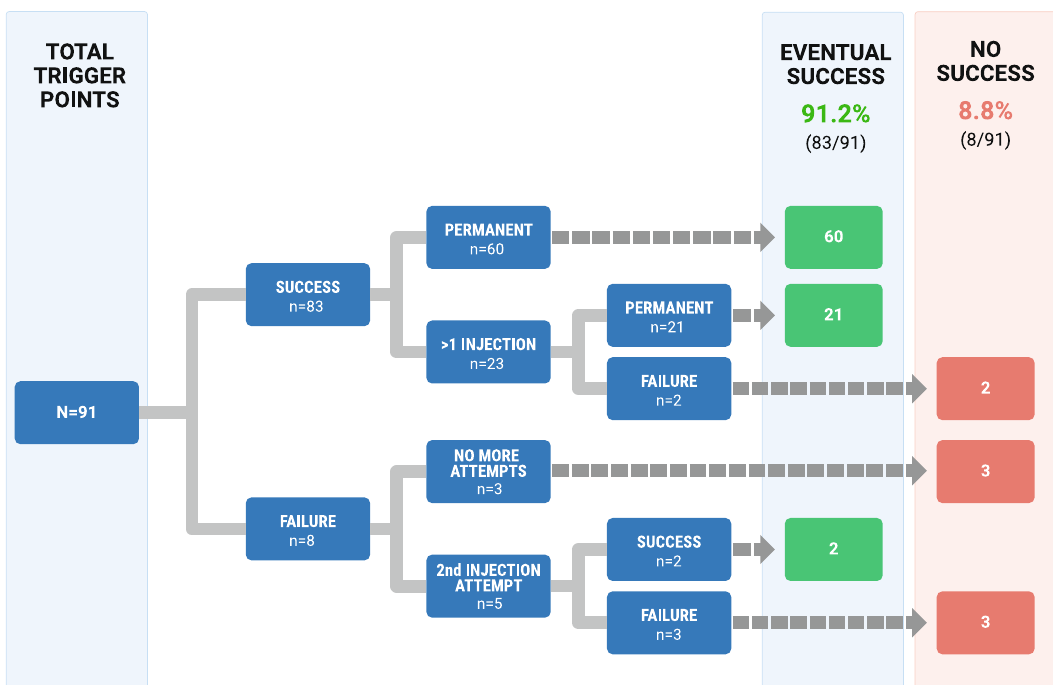
Fig. 1 Overall outcomes for trigger points.